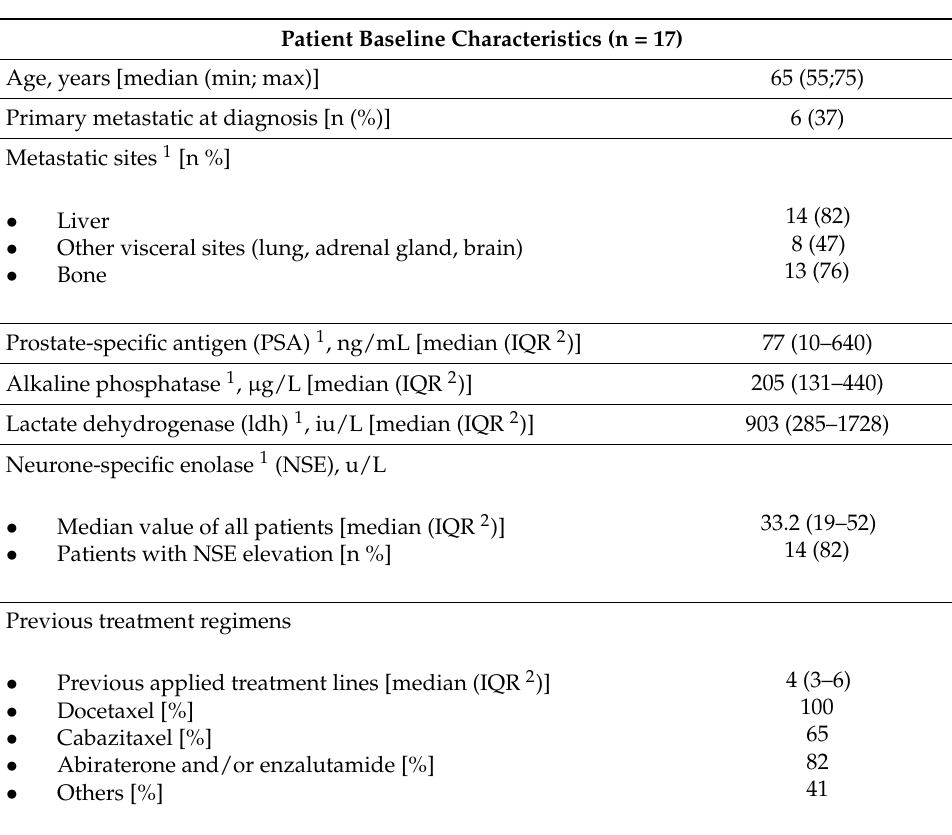
Table 1. Baseline characteristics of mCRPC patients treated with